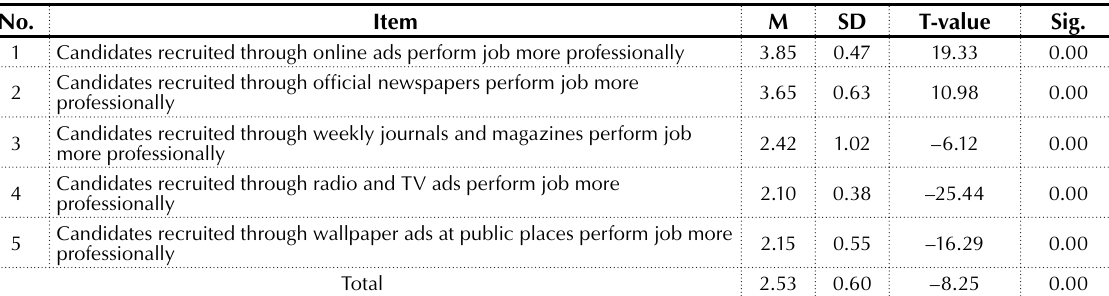
Table 6. Means, standard deviations, t-values, and significance of external sources of recruitment related to “job